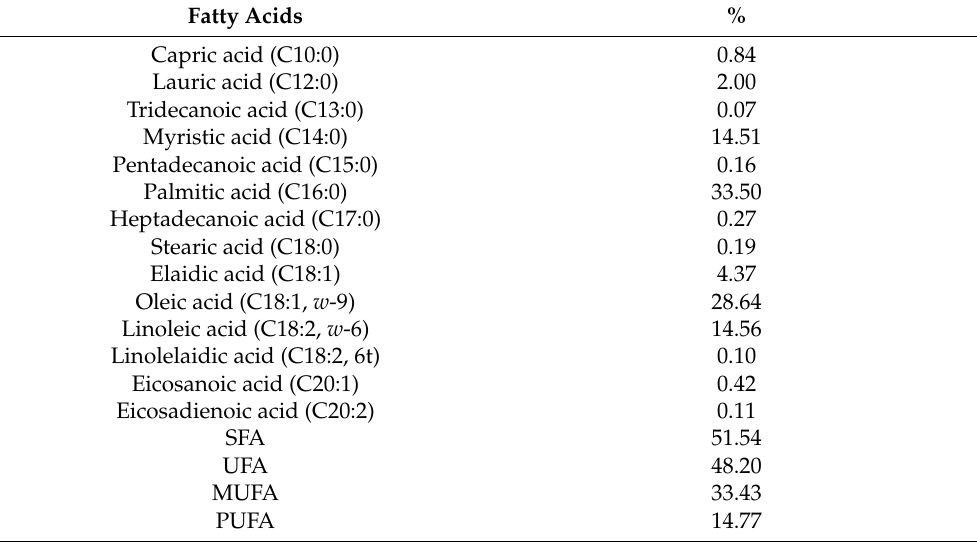
Table 1. The fatty acid composition of bati